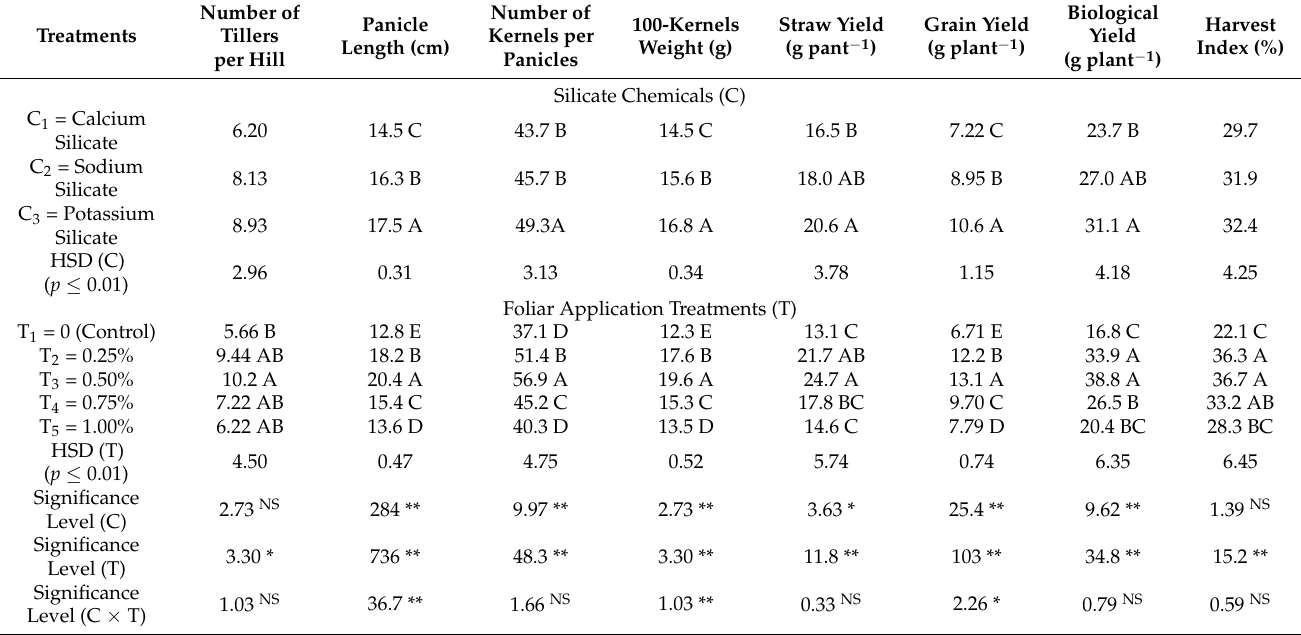
Table 2. Effect of silicate chemicals, with various doses of foliar applications, on the yield attributes of rice grown in Cd-contaminated